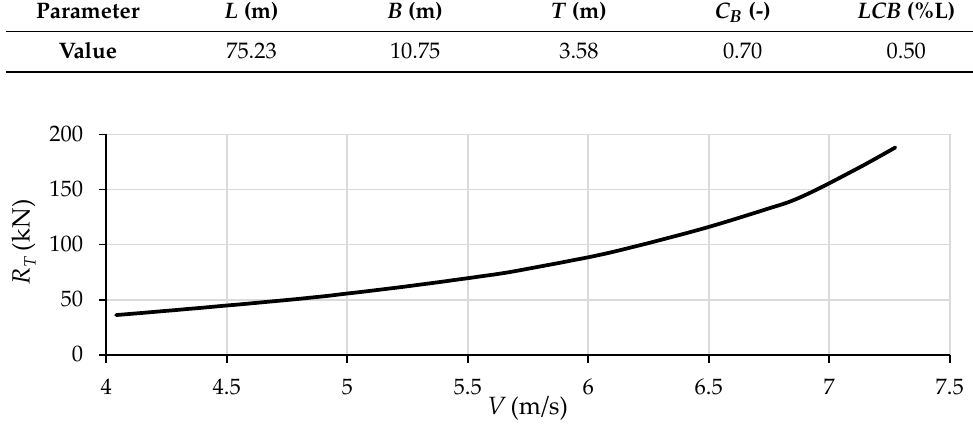
Figure 4. The resistance of the Series 60 ship considered in this study for the whole speed range.